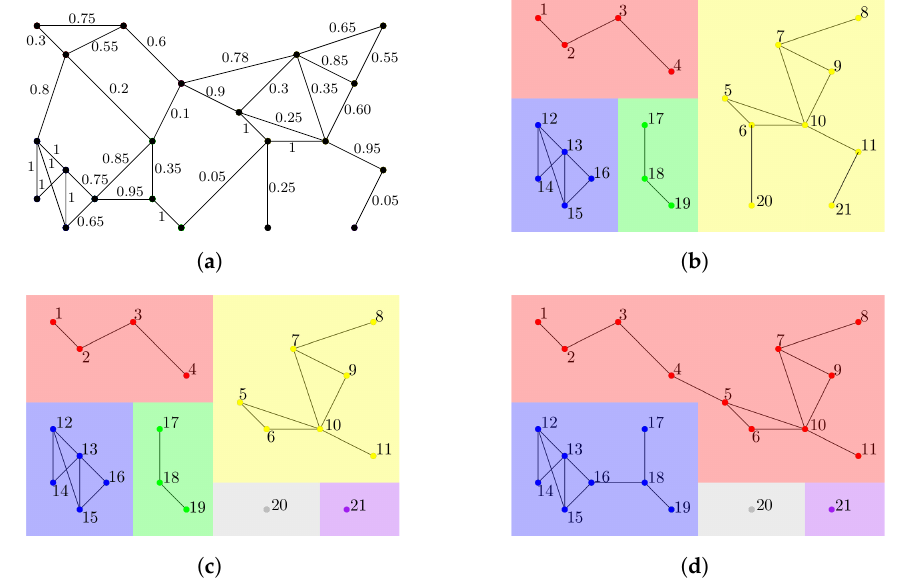
Figure 1. Random connection graph C and three possible realizations and cluster formations. We show each cluster with a different color. ( a ) Probabilities of the edges; ( b ) a realization of C with four clusters; ( c ) a realization of C with six clusters; ( d ) a realization of C with four